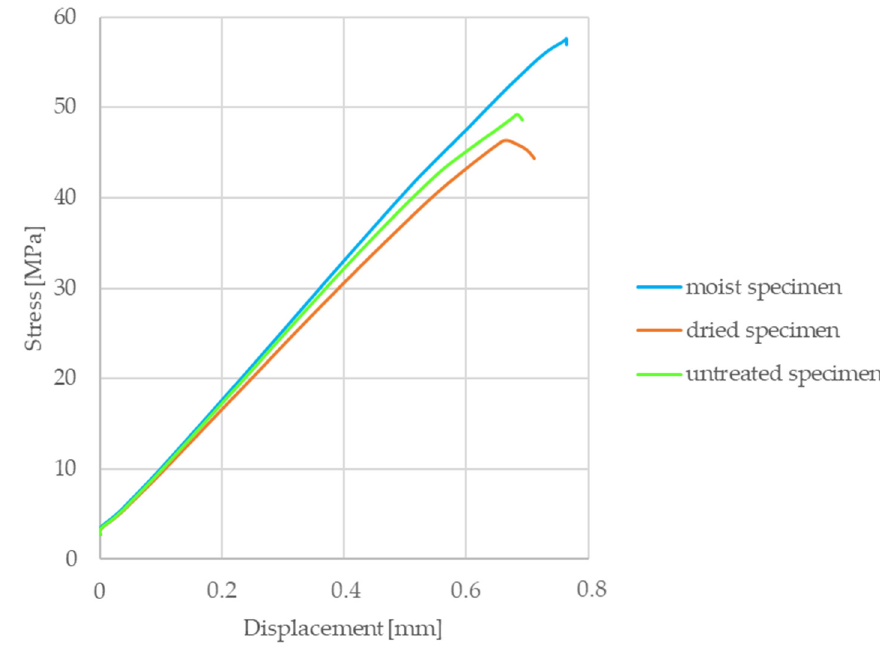
Figure 10. Force–displacement curves of test samples with different moisture levels.